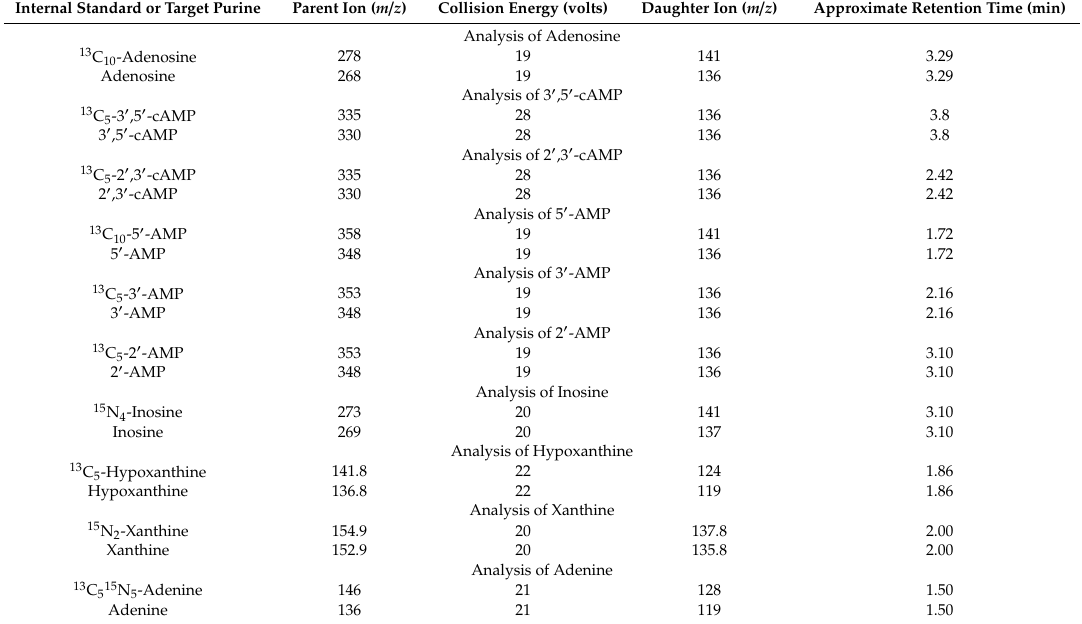
Table 1. Adenine panel.